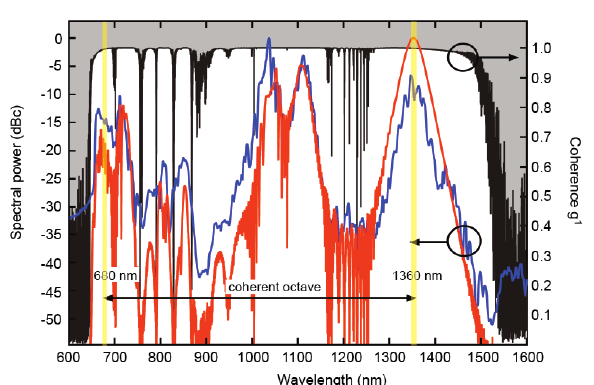
Figure 3. Octave-spanning SC spectrum generated in a PCF from the output of an Yb:CALGO DPSSL with gigahertz repetition rate: comparison between the measured (blue) and simulated (red) spectra. The Raman soliton at 1360 nm and the dispersive wave at 680 nm (shown by the yellow areas) are distant of one octave and have a high degree of coherence g 1 shown by the black curve displayed with respect to the right vertical axis; they are used to generate the CEO beat in an f -to-2 f interferometer. (Reproduced with permission from [21]. © The Optical Society of America,